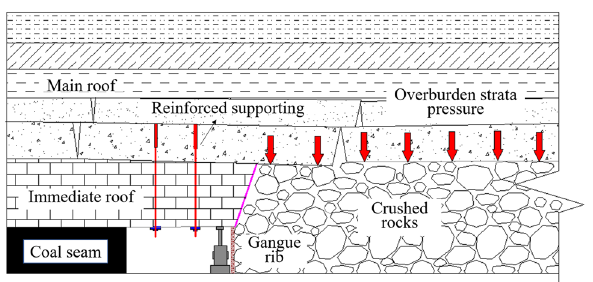
Fig. 1 Schematic diagram of surface subsidence in